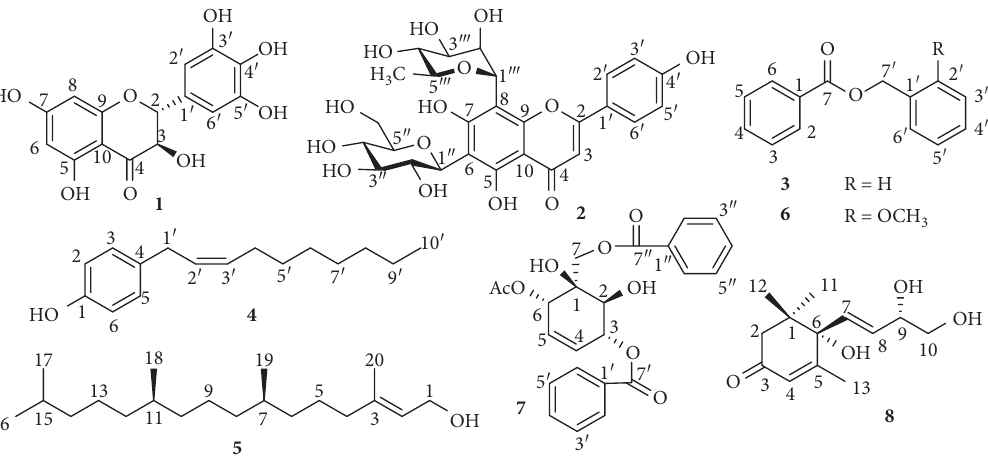
Figure 1: Structure of compounds 1 – 8 from P. bavinum